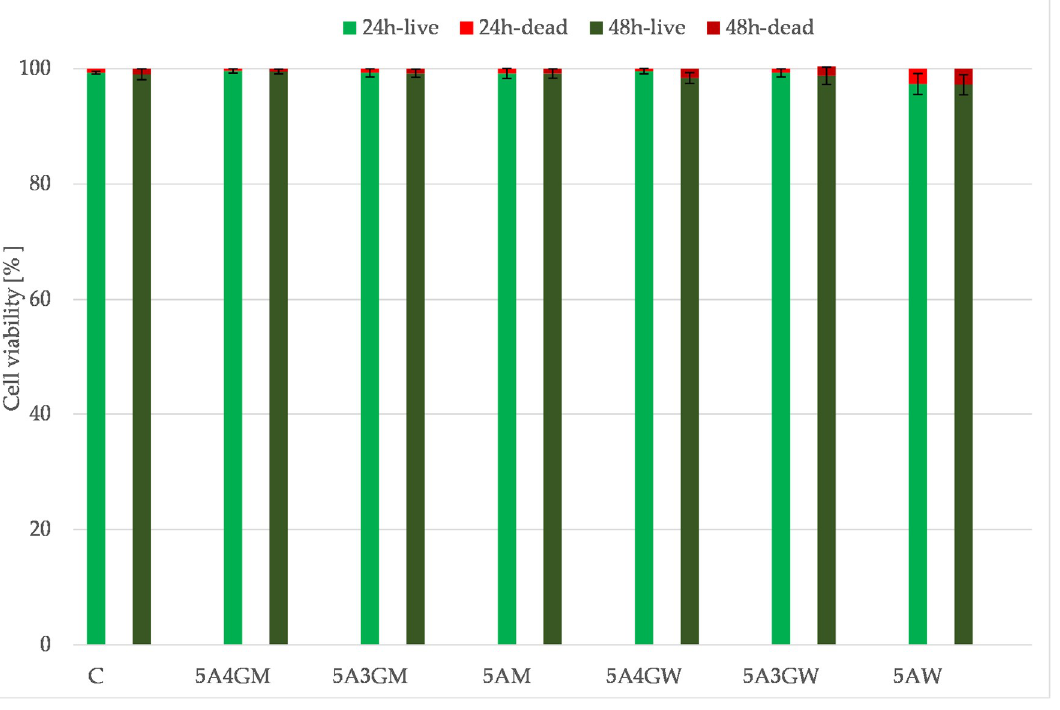
Figure 9. Endothelial cells (EA.hy 926 line) viability after indirect contact with samples dissolved in water (W) and full culture medium (M) with different content of gelatine after 24 and 48 h of incubation.